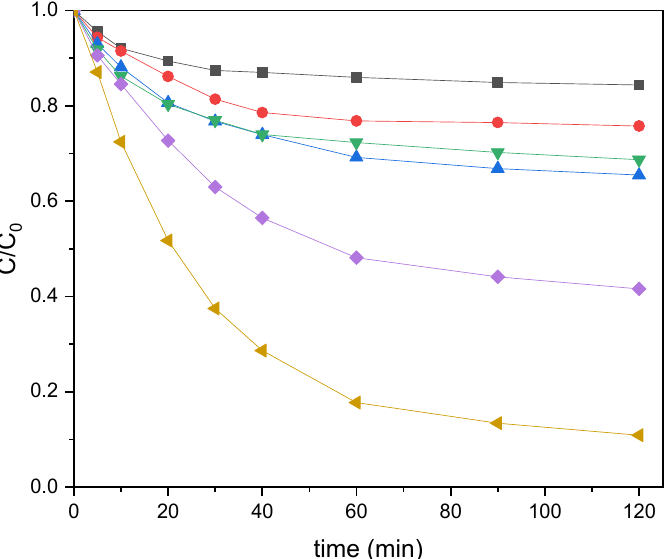
Figure 3. Degradation profiles with Fe-DES: 0.26 mM (black line), 0.53 mM (red line) and 0.81 mM (blue line) concentrations for the Fenton treatment; and 0.26 mM (green line), 0.53 mM (purple line) and 0.81 mM (yellow line) concentration for the A-PMS treatment.